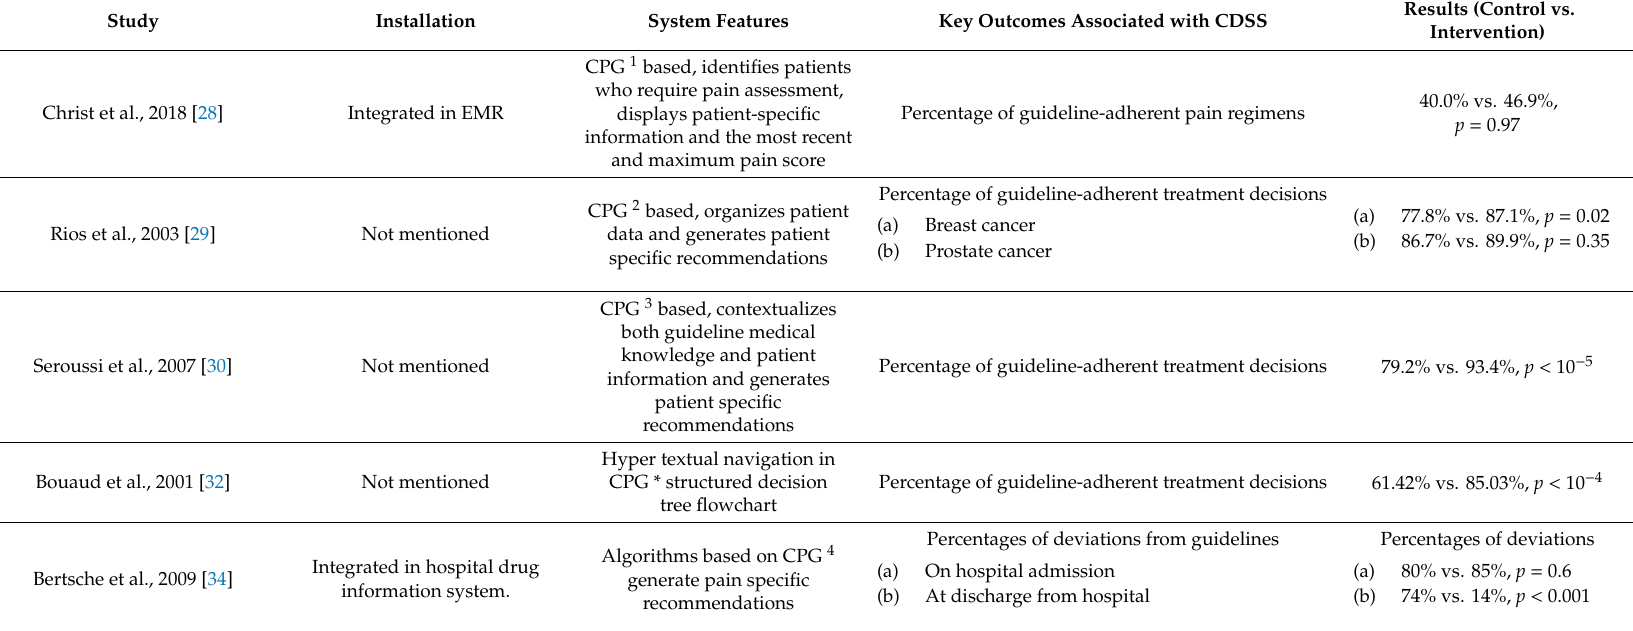
Table 3. Impact of CDSS on Guideline